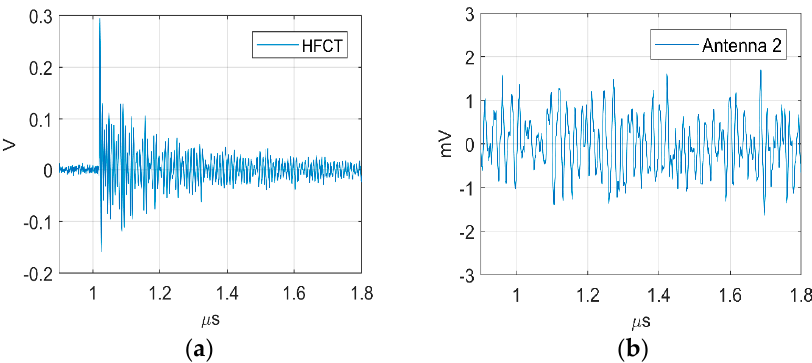
Figure 20. ( a ) Largest corona discharge HFCT; ( b ) Largest corona in the antenna at position 2.